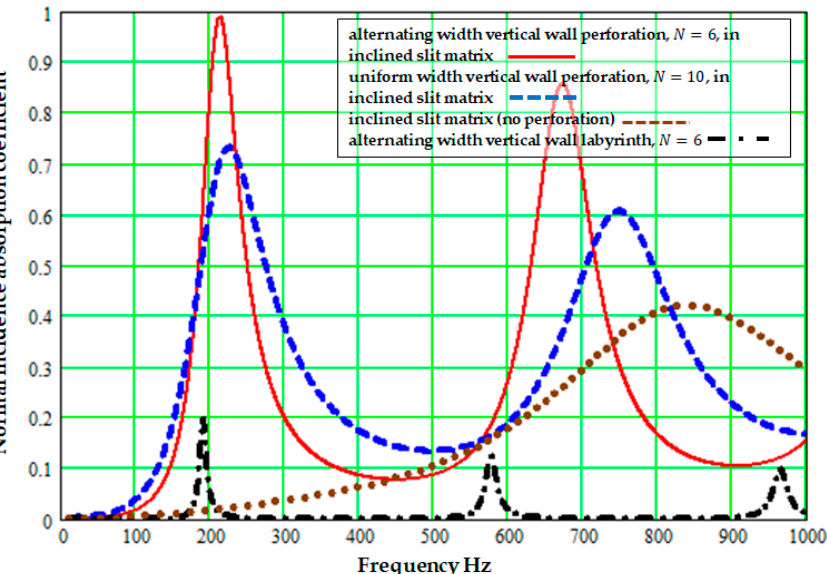
Figure 8. Normal incidence absorption coefficient spectra predicted for 0.045 m thick hard-backed layers consisting of either an alternating width ( w = 1 mm, b = 3 mm, l = 40 mm, δ = 8, N = 6, continuous line) or a constant width ( w = 1 mm, b = 3 mm, l = 40 mm, N = 10, broken line) vertical-wall labyrinthine slit in a slit-pore matrix (0.3 mm wide slits at 60 ◦ to the normal, porosity 0.1). The dash-dot line is the prediction for the same labyrinthine slit perforation in a non-porous solid and the dotted line is the prediction for the slit pore medium alone (no perforation).